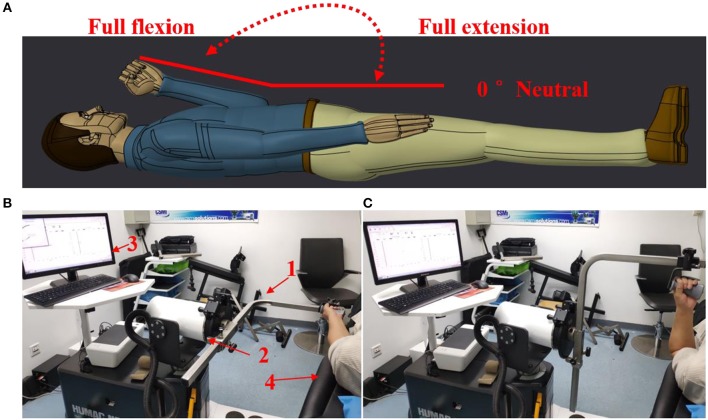
Experimental setting. (A) The definition for the range of movement with elbow joint. (B) Maximum isometric voluntary contraction at an elbow joint angle of about zero degree Test for both arms and HUMAC NORM device introduction, 1: elbow/shoulder handle, 2: dynamometer, 3: computer display and control platform, 4: examination bed; (C) Elbow passive isokinetic contractions test for impaired limb.